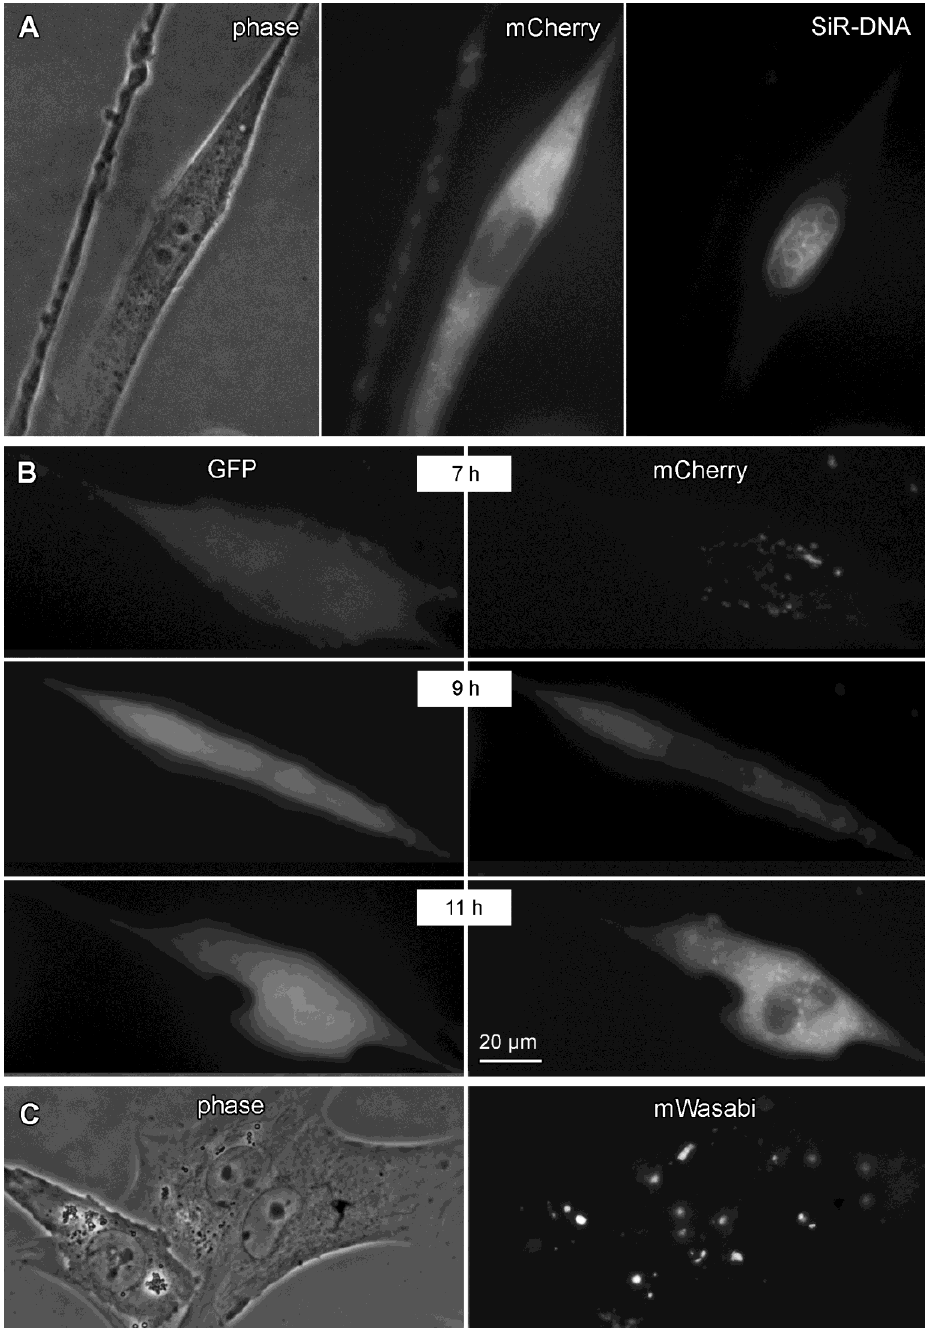
Figure 5. High magnification fluorescence microscopy shows distinctive fluorescence pattern of GFP, L-mCherry, and L-mWasabi. ( A ) Assessment of putative viral inclusion bodies: BHK-21 cells were infected with VSV-L-mCherry at MOI of 10. Images of one representative cell in phase contrast, tetramethylrhodamine (TRITC), and infrared (0.5 µM SiR-DNA for nuclear staining) channel are shown. ( B ) Assessment of the kinetic of GFP vs. mCherry fluorescence in time-lapse recording: BHK-21 cells were infected with VSV-GFP-L-mCherry at MOI of 10. Images were acquired for 12 h after infection. Images of one representative cell in fluorescein isothiocyanate (FITC) and TRITC channels at three time points are shown. ( C ) Assessment of putative viral inclusion bodies in a representative micrograph of BHK-21 cells infected with VSV-L-mWasabi at MOI of 10. Scale bar: 20 μm.